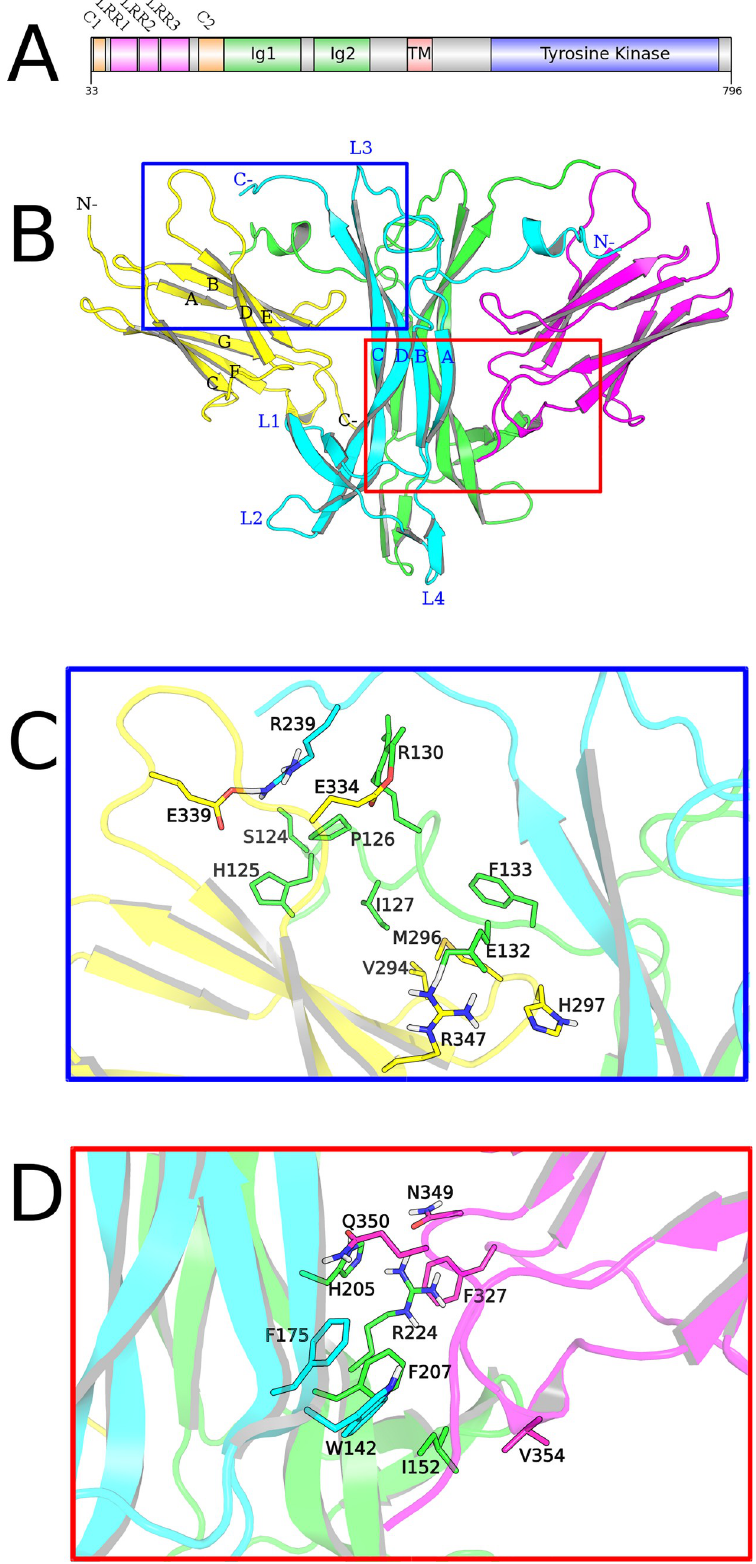
Fig 2. NGF/TrkA-Ig2 complex and binding sites. (A) Domain organization of TrkA. Domains are colored in: orange, cysteine-rich clusters (C1-2); in magenta, leucine-rich repetitions (LRR1-3); in green, immunoglobulin-like